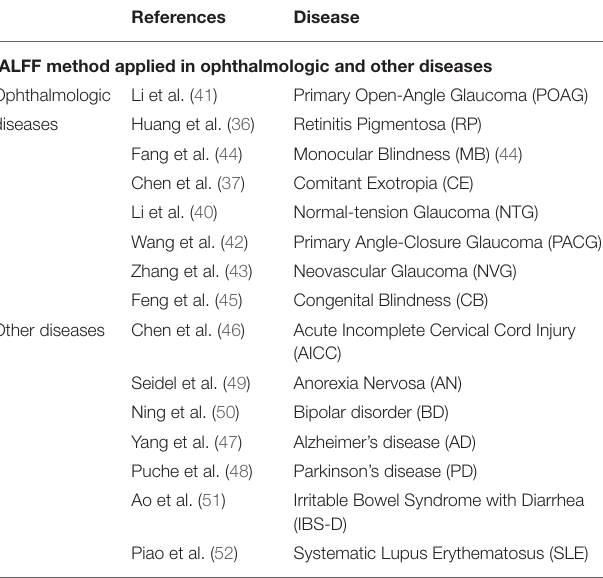
TABLE 1 | fALFF method applied in ophthalmologic and other